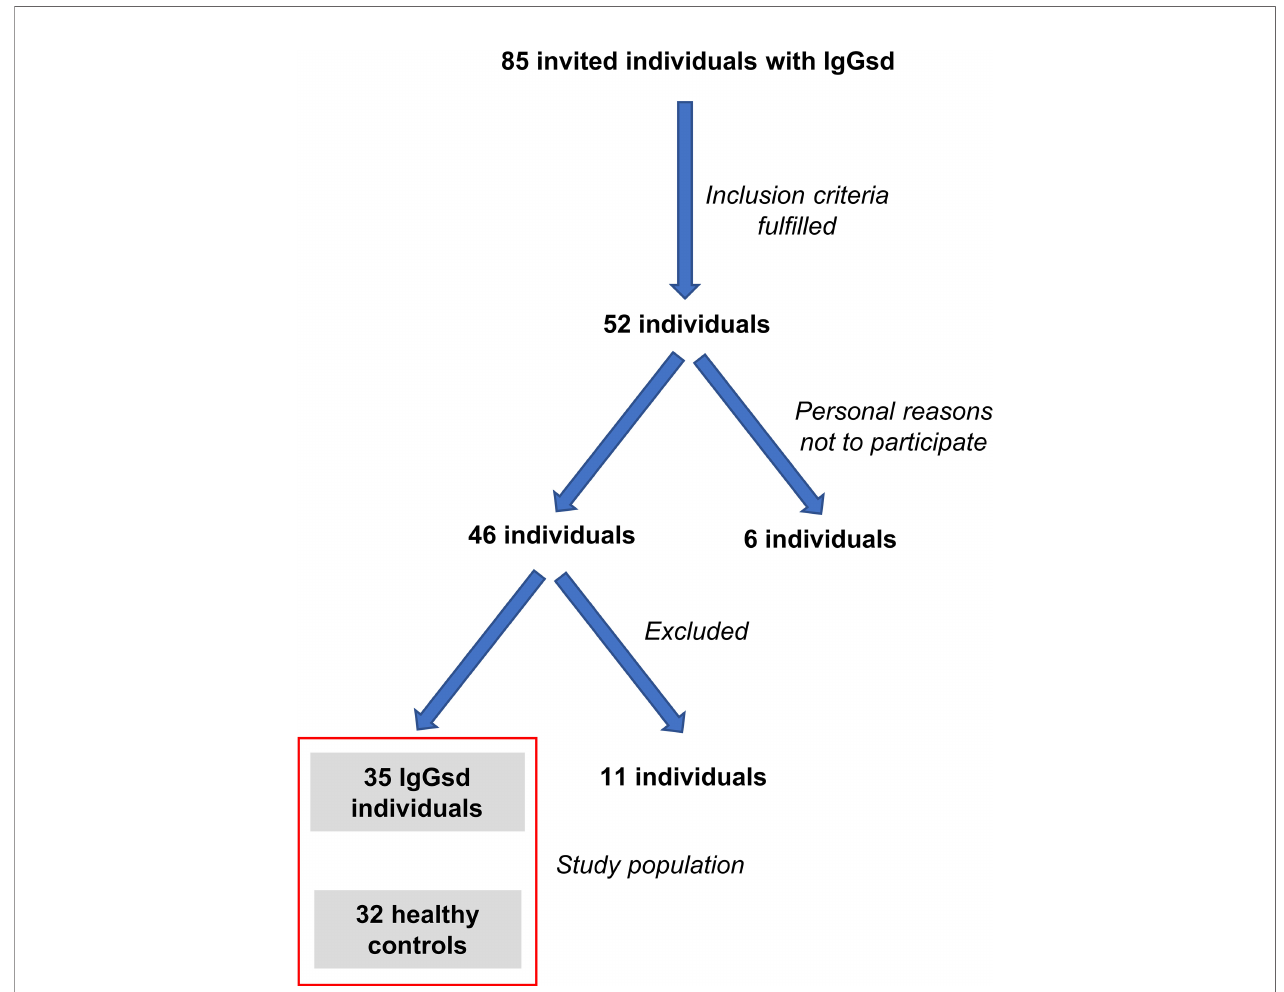
FIGURE 1 | Flow chart of individuals included in the study. Of 85 individuals with IgG subclass de fi ciency (IgGsd) 52 met the inclusion criteria of the study. Six individuals chose not to participate due to personal reasons. Another 10 individuals were excluded since they did not start IgG-replacement therapy in time for inclusion and one individual was excluded due to uncon fi rmed diagnosis. Healthy controls were recruited among blood donors and matched for gender and